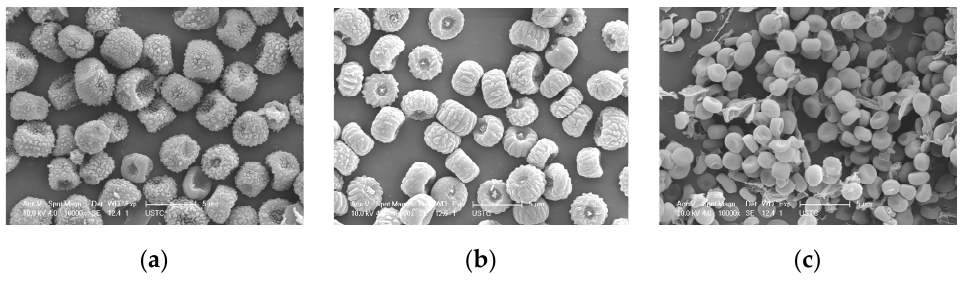
Figure 1. SEM images of microbial spores (10,000× magnification, scale 5 μ m). ( a ) AO spores; ( b ) AN spores; and ( c ) BB spores.